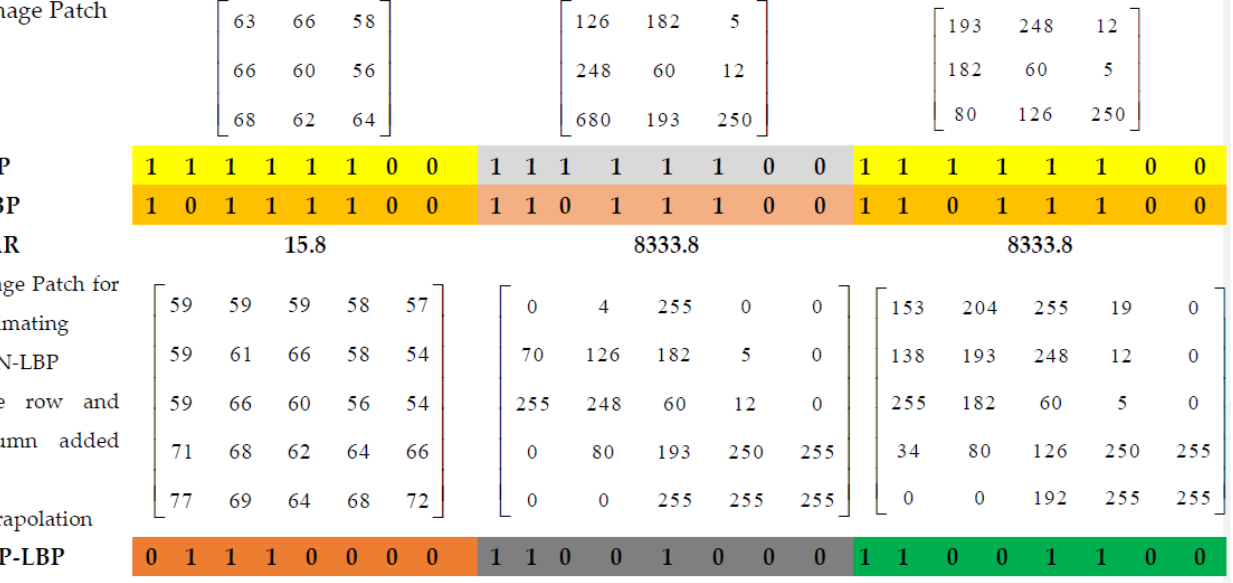
( b2 ) Figure 5. Example for effective edge preservation by proposed AvN-LBP. ( a , b ) Two image patches of size 5 × 5. ( a1 , b1 ) AvN-LBP preserves weak edge patterns. Two 5 × 5 example image patches are shown in ( a , b ). ( a1 , a2 ) are the patterns given by LBP for ( a , b ), respectively. ( b1 , b2 ) AvN-LBP pat- terns of ( a , b ), respectively.